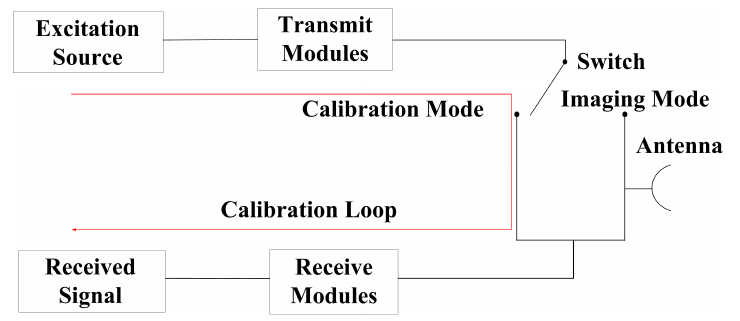
Figure 5. Schematic diagram of an internal calibration